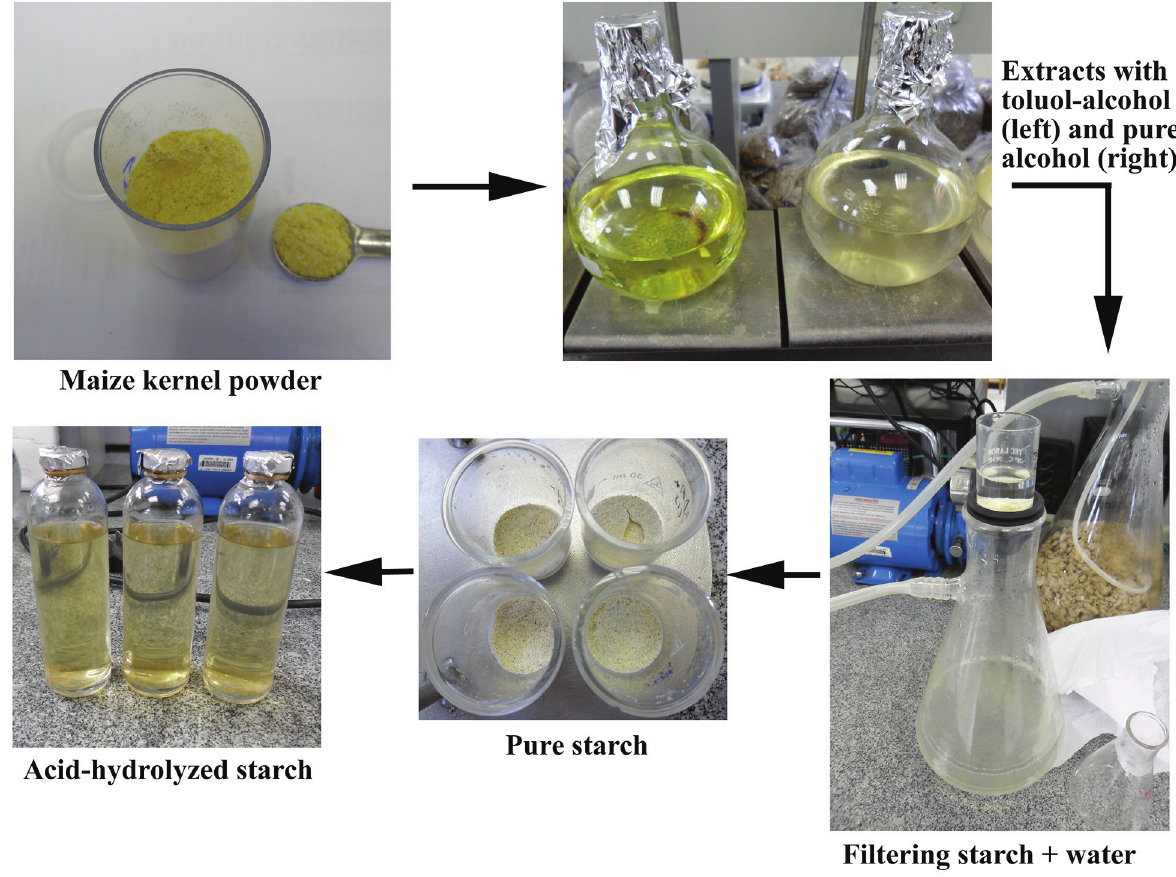
Figure 1 - Carbohydrate quantification steps in pure maize